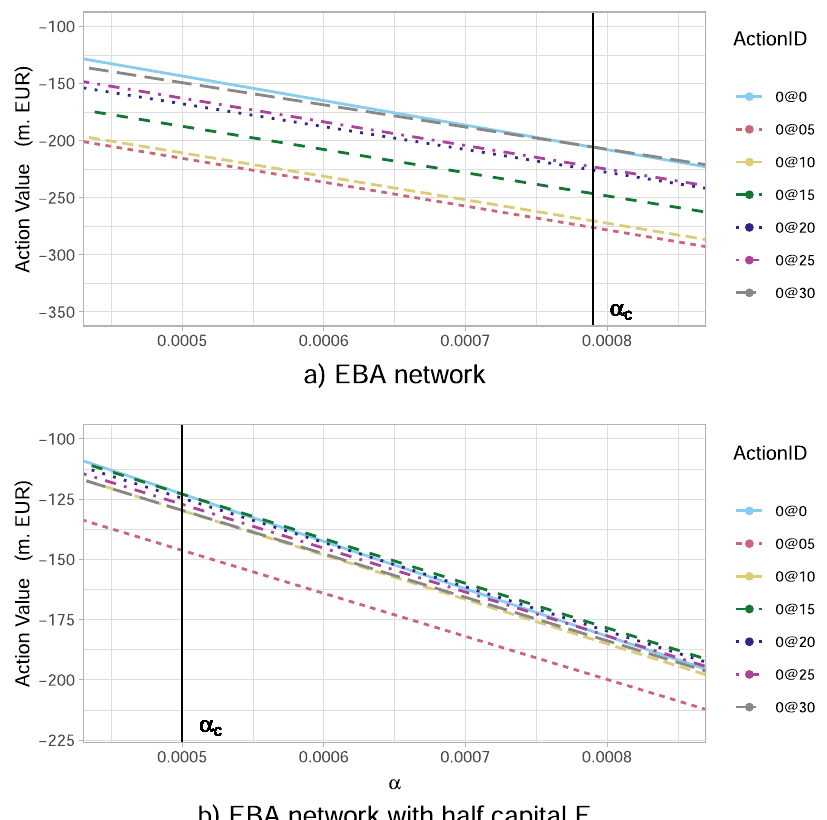
Fig. 8 | Theoptimalactionvalue Q * ( s 0 , a 0 ) fortheEuropeanBanking Authority (EBA) network at time 0 as a function of the percentage α of wealth loss upon default. In the legend, the ActionID 0@0 means no investment, 0@05 means investing 0.5 in all the nodes, etc. a There is a critical value of α given by α c ≈ 0.00079, beyond which the inaction of the government is no longer optimal. In particular,for α justabovethecritical α c